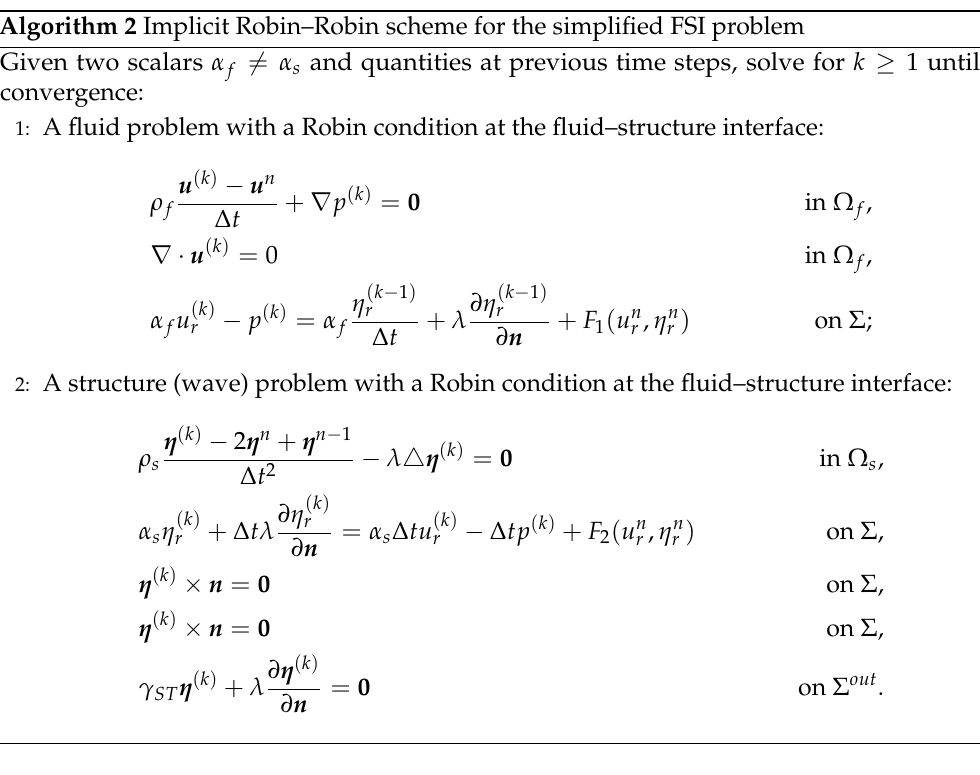
Algorithm 2 Implicit Robin–Robin scheme for the simplified FSI